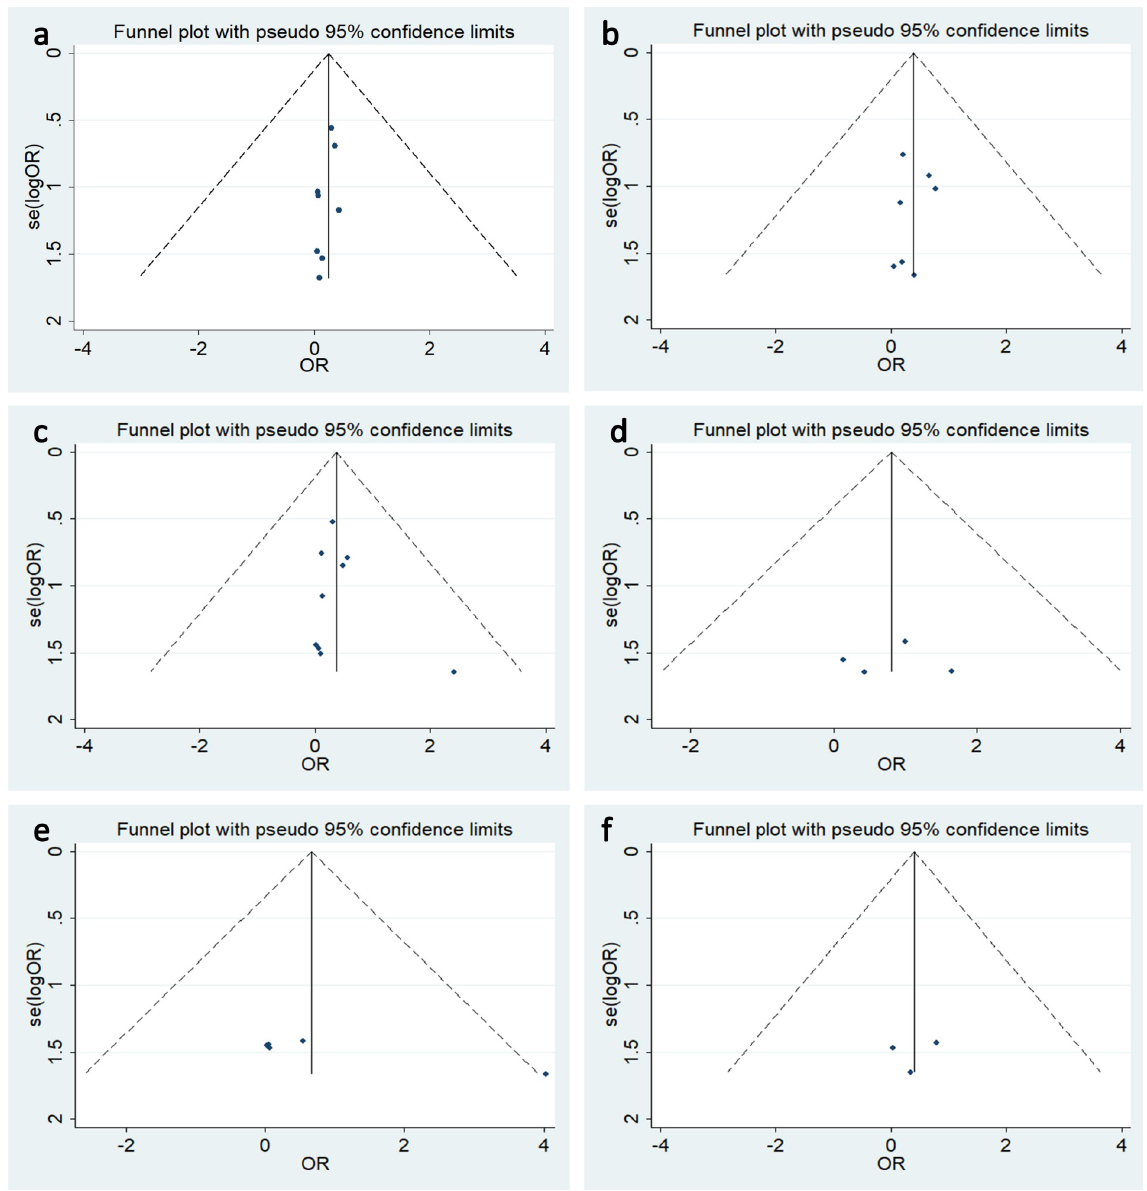
Fig 5. Funnel plot for publication bias test for the relationship of TIVAP and PICC with the risk of follow complications. (a)occlusion, (b) malposition, (c) catheter-related thrombosis, (d) extravasation, (e)phlebitis, (f) allergy.